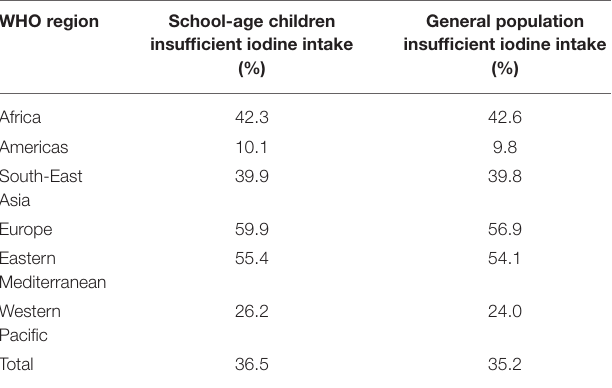
TABLE 1 | Percentage of population (school-age children, 6–12 years and general population, all age groups) with insufficient iodine intake (UI < 100 µ g/L) by WHO region: surveys carried out in